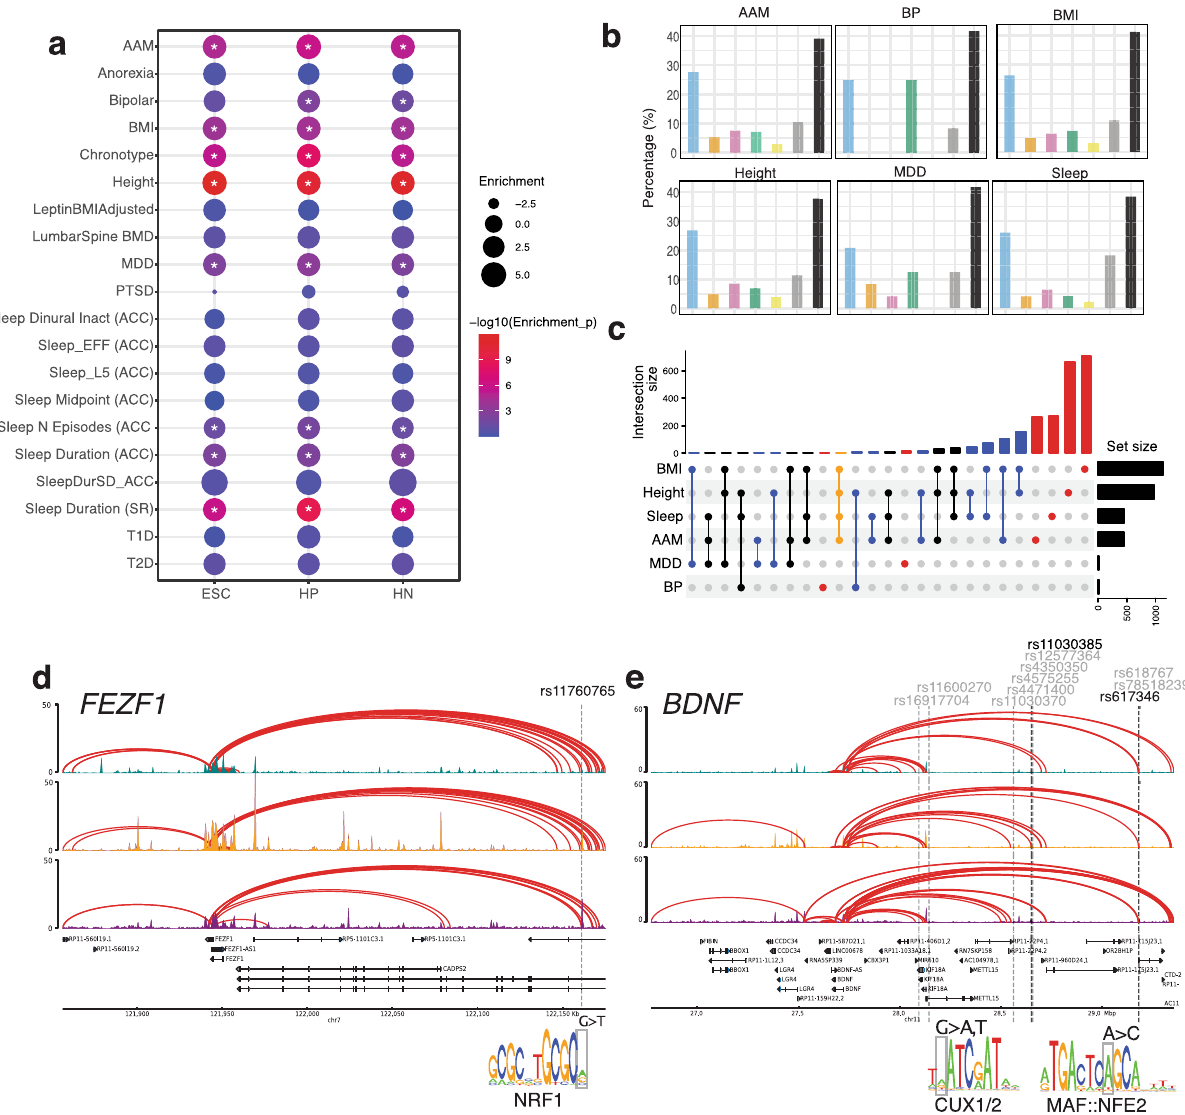
Fig. 4 Putative cis -regulatory elements are enriched for GWAS signals of complex traits. a Partitioned LD score regression of ESC, HP, and HN cRE against the indicated genome-wide signal. Circle size indicates the enrichment of estimated heritability, and color indicates statistical signi fi cance. b Proportion of genes from our variant-to-gene mapping located in each DE cluster (Fig. 2a) or non-DE genes (black). c Comparison of genes implicated in our variant-to-gene mapping analysis for each GWAS. Dots and lines indicate the intersect of the set of genes found in each GWAS. Top: the number of genes in different overlapping sets. Right: the number of SNPs detected in each GWAS. d FEZF1 genomic locus with interactions connecting to a distal cRE. The SNP is located in a putative NRF1 motif. e Genome track for the BDNF locus. Multiple proxies in open regions are shown. Two proxies located in putative TF motifs for CUX1/2 and MAF::NFE2 are